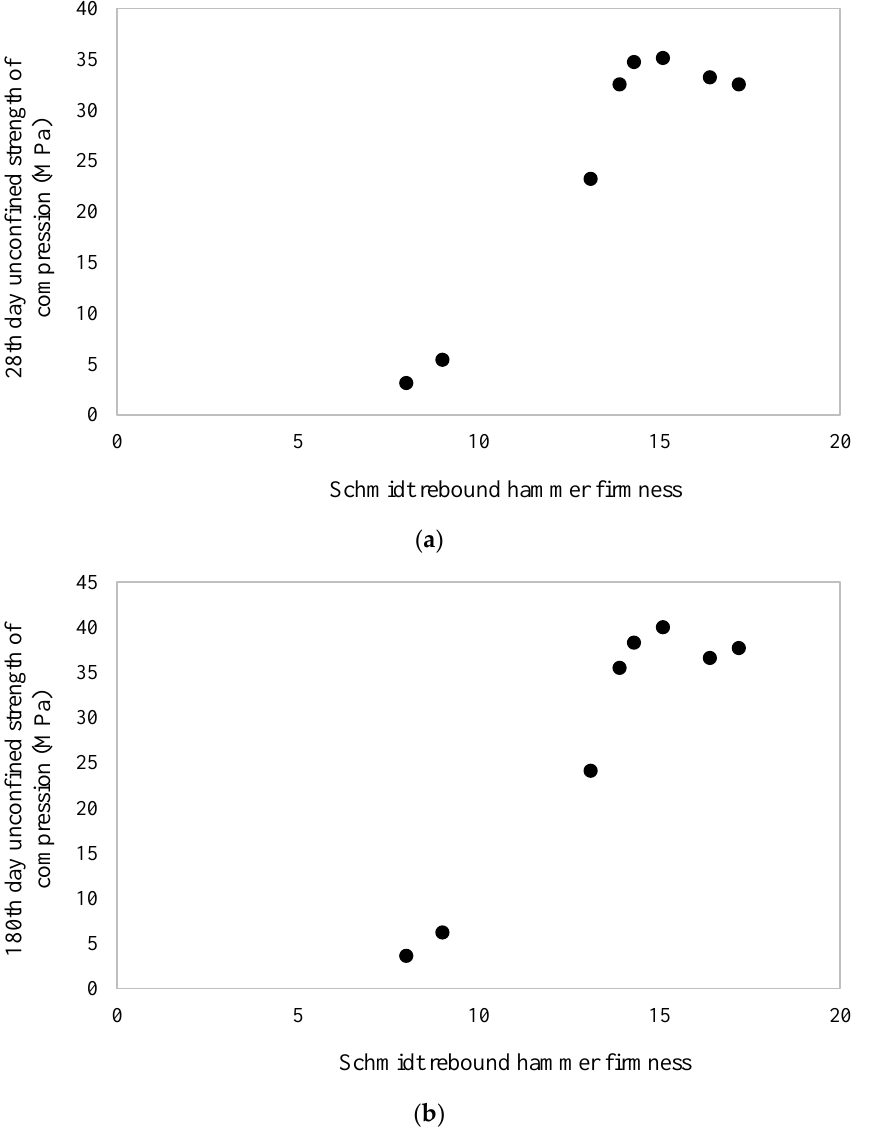
Figure 4. Powerful correlation among the unconfined strength of compression and Schmidt surface hardness on the ( a ) 28th day and ( b ) 180th day.